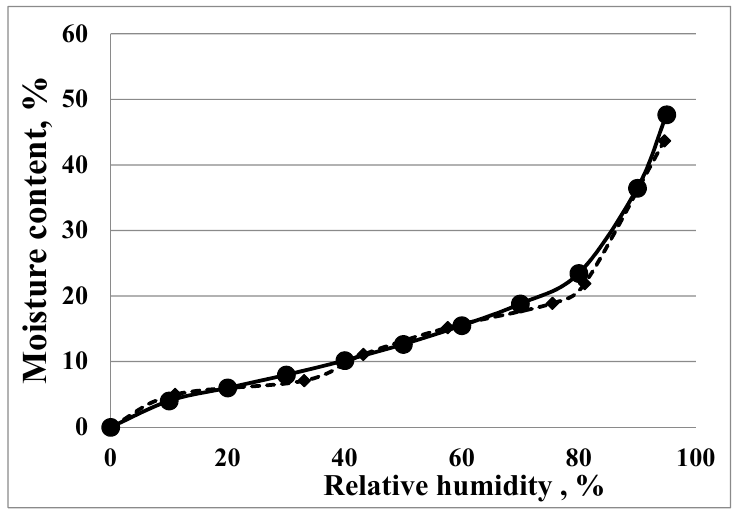
Figure 1. Experimental sorption isotherms, obtained by two independent methods: (- ● -) DVS and (- ♦ -) static-gravimetric, for DDA:Gel 1:3 cryogel.